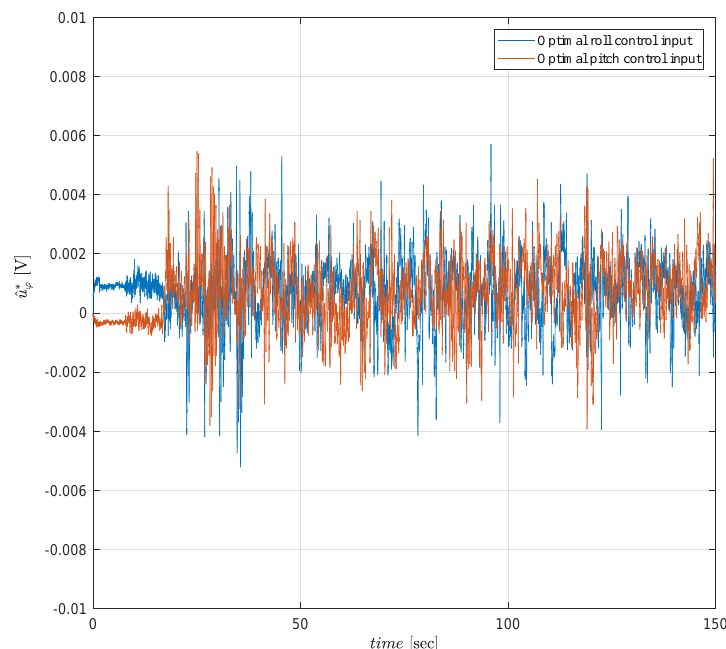
Figure 13. Optimal attitude control inputs for the Kalman filter.